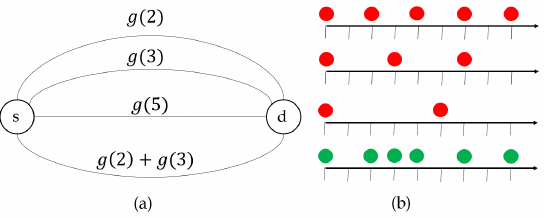
Figure 4. The complete coverage in the deterministic case, link 4 is completely covered by both links 1 and 2 together. Hence, it can be completely pruned. ( a ) shows a simple source-destination network resembling an example. ( b ) shows the times at which each link transmits where the fourth one is completely covered by the